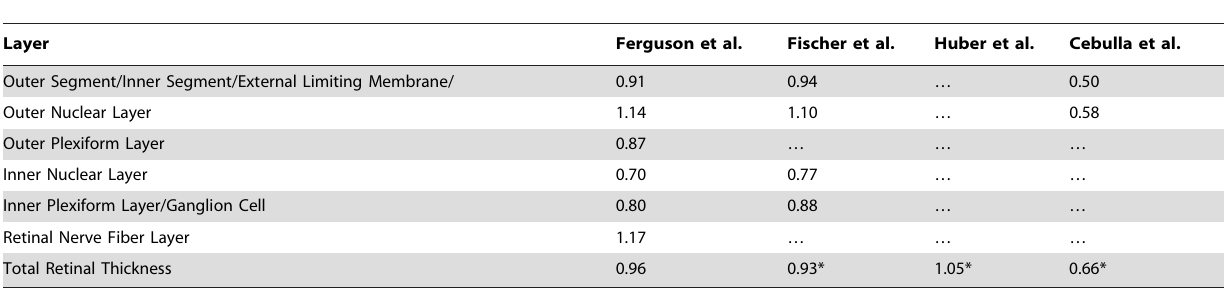
Table 4. Comparison of SD-OCT/histology ‘correlation constant’ between present and prior studies.